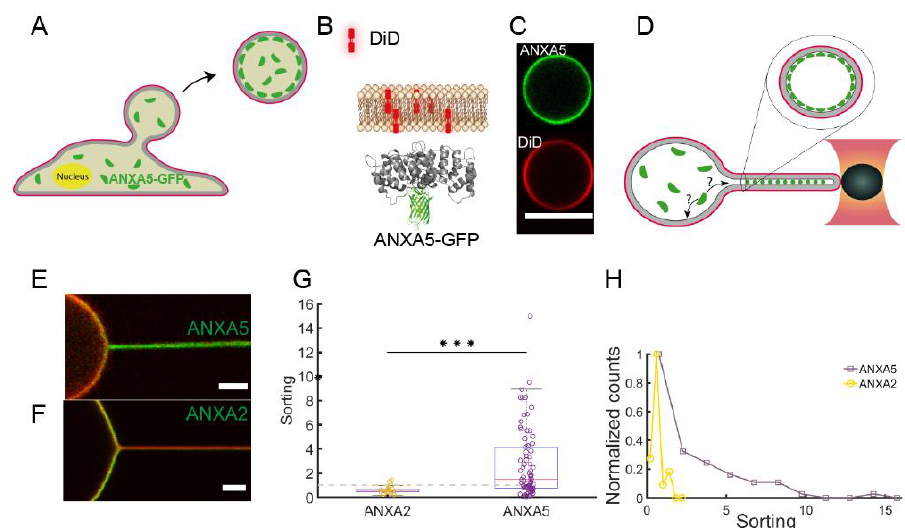
Figure 2. Membrane curvature sensing of ANXA2 and ANXA5 measured in lipid nanotubes extracted from Giant Plasma Membrane Vesicles (GPMVs). ( A ) GPMVs are derived from HEK293T cells expressing ANXA2-GFP or ANXA5-GFP. ( B ) GFP tagged annexins bind to the inner side of the lipophilic carbocyanine DiD labeled membrane. ( C ) Images of DiD (red) labeled GPMVs containing ANXA5-GFP (green). ( D ) Schematic of optical manipulation of the vesicles to form nanotubes with radius ~50nm and length 10 µ m. ( E ) Overlay image of a GPMV and nanotube containing GFP tagged ANXA5 and DiD membrane label. ( F ) Overlay image of a GPMV and nanotube containing GFP tagged ANXA2 and membrane label DiD. ( G ) Quantification of curvature sorting for ANXA2 and ANXA5, respectively. The dashed line represents Sorting = 1 corresponding to no sorting. *** p = 0.004. ( H ) The Sorting values from ( G ) plotted as a histogram which reveals significant heterogeneity in the Sorting by ANXA5. Reproduced with permission from